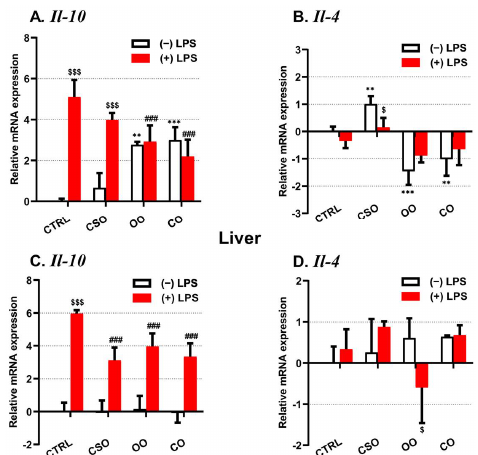
Figure 4. Effect of cactus seed oil, olive oil, or colza oil treatment on gene expression of the anti- inflammatory markers Il-10 ( A , C ) and Il-4 ( B , D ), in the brain and liver, respectively. Male C57BL/6 mice received for 28 days a standard diet (control (CTRL)), a diet enriched with 6% ( w / w ) CSO, OO, or CO, and intravenous injection of LPS (100 µg) four hours antemortem. First, total RNA was iso- lated from mice brains or livers, and then the expression level of genes of interest was quantified by real-time RT-qPCR. All values are means ± SD (n = 4 – 6), statistical significance of higher mean signal (*** p ≤ 0.001. ** p ≤ 0.01) compared to control, (### p ≤ 0.01. # p ≤ 0.05) compared to LPS, and ($$$ p ≤ 0.001. $ p ≤ 0.05) compared to the different treatments with or without LPS administration. Statis- tics were executed using two-way ANOVA followed by Tukey test for multiple comparisons.